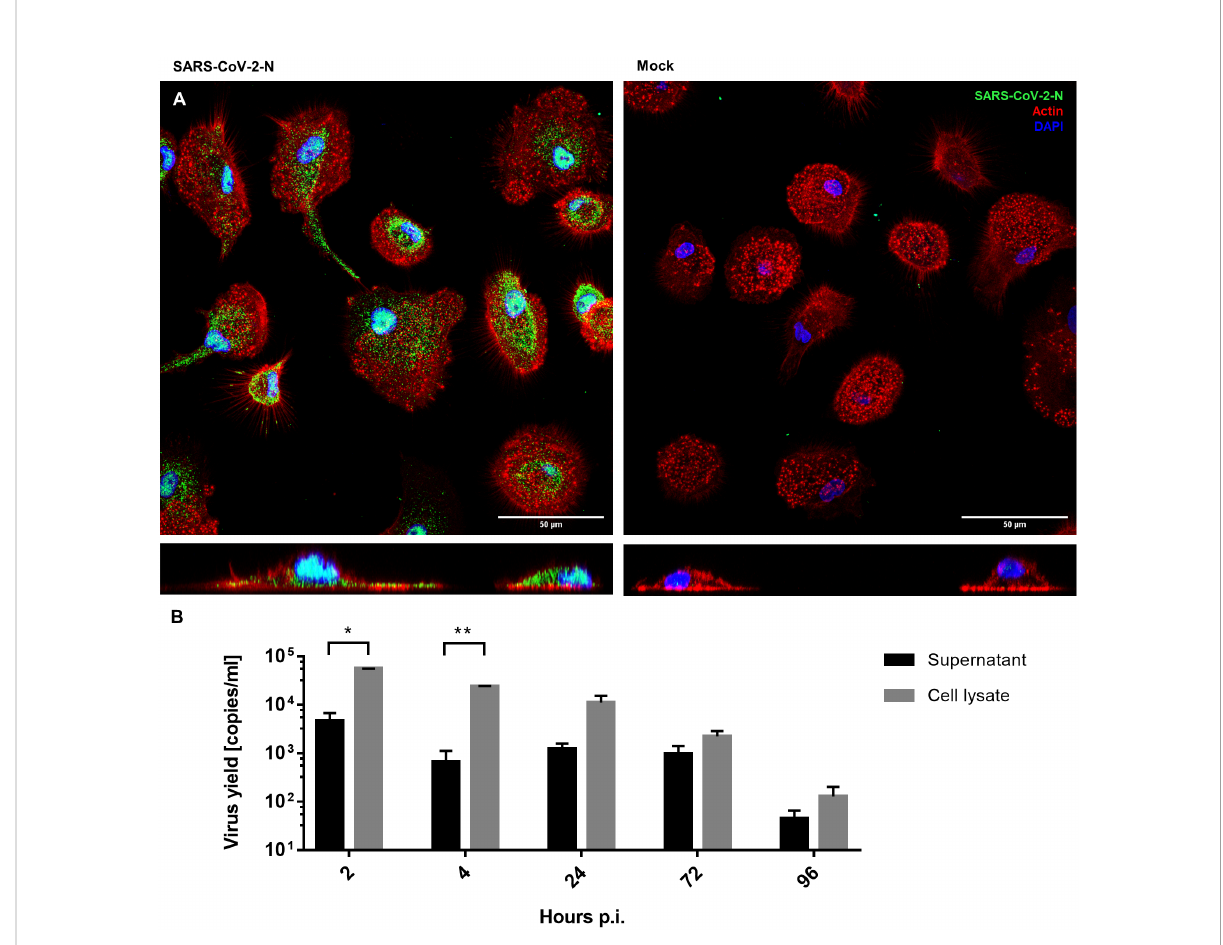
FIGURE 1 hMDMs infected with SARS-CoV-2 virus or inoculated with mock. (A) Confocal microscopy images of SARS-CoV-2-infected and mock-infected macrophages 48 h p.i., showing the virus N protein (green), actin (red), and nuclei (blue). The bottom panels show an orthogonal view of cells. (B) Virus yield (viral RNA copies/ml, as determined with RT-qPCR) in cell culture supernatants and cell lysates of infected hMDMs. The experiment was carried out in triplicate and means ± SEM are shown. Groups were compared by paired T-test. *p < 0.05.